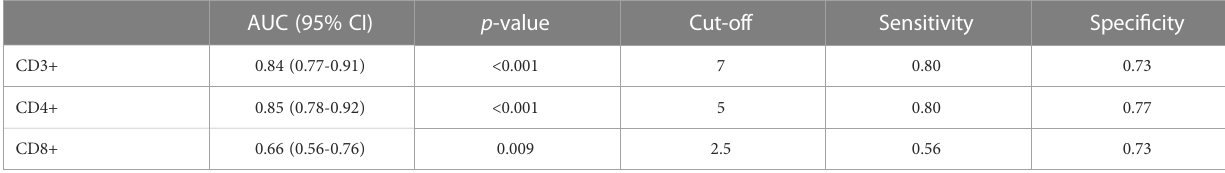
TABLE 2 ROC curve for evaluating the capacity of T-cell reactivity (blast formation) to discriminate convalescent COVID-19 patients from healthy controls. AUC (95% CI) p -value Cut-off Sensitivity Speci fi city CD3+ 0.84 (0.77-0.91)